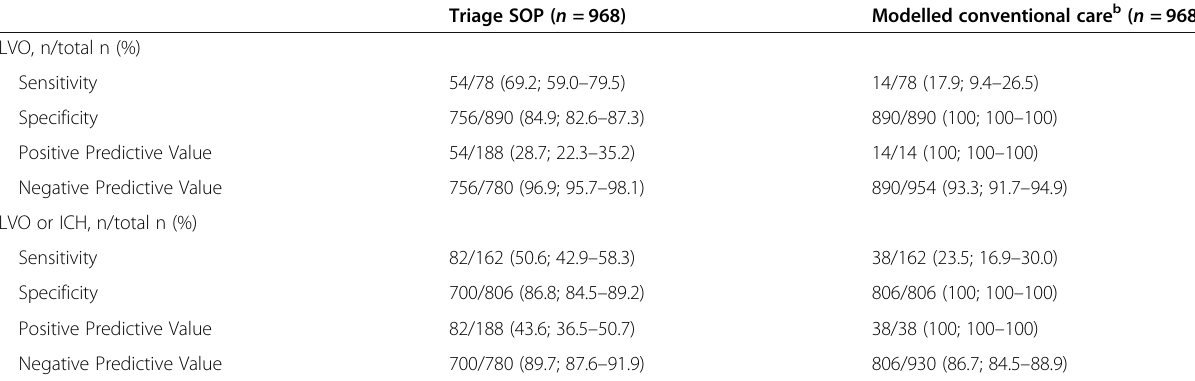
Table 2 Performance of the triage SOP and modelled conventional care assessed via geocoding in patients with LVO and with LVO or ICH a Triage SOP ( n =